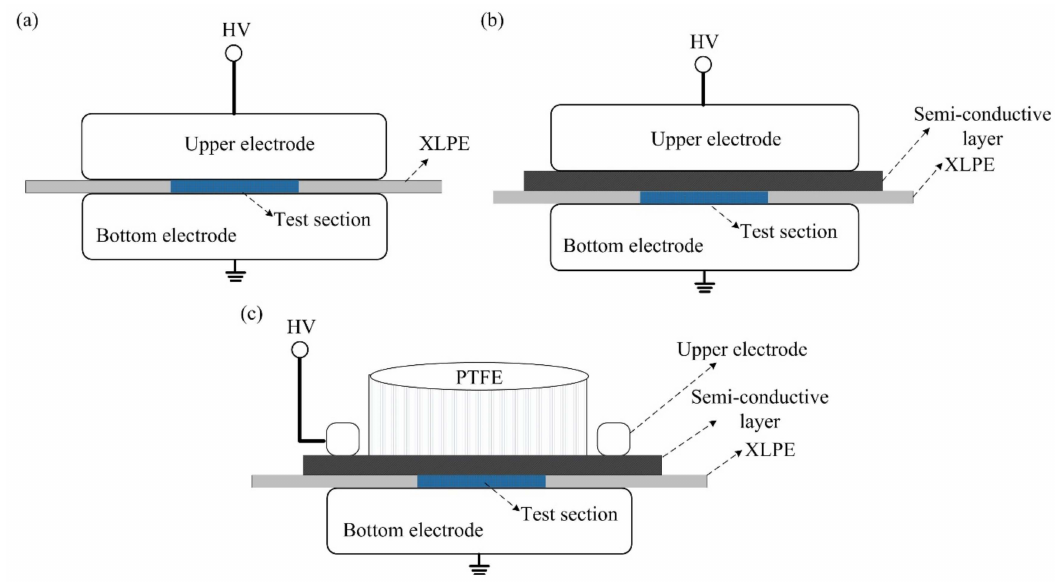
Figure 4. Schematic diagram of electrode structures with di ff erent high voltage terminals. ( a ) The traditional electrode structure of Metal upper electrode- Insulation material Metal bottom electrode (M-I-M); ( b ) the simplified cable electrode structure of Metal upper electrode-Semi-conductive electrode- Insulation material- Metal bottom electrode (M-S-I-M); ( c ) the electrode structure of Semi-conductive composites- Insulation material- Metal bottom